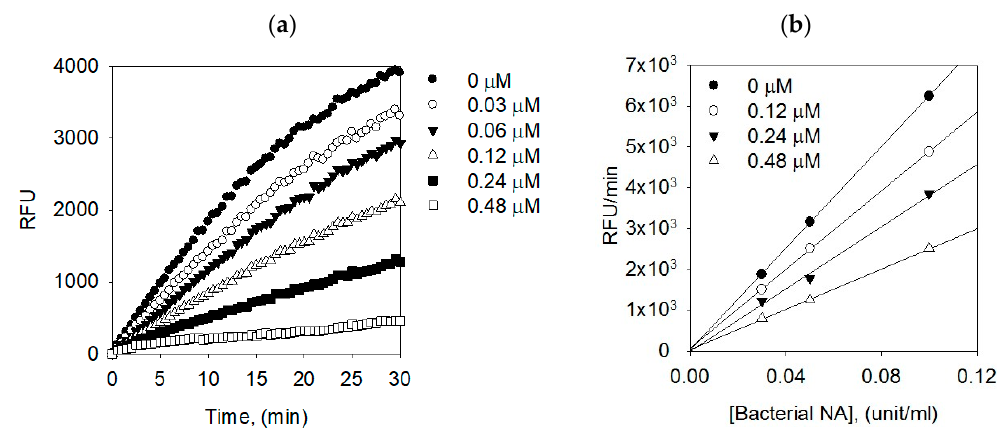
Figure 4. ( a ) Dose-dependent inhibition of bacterial neuraminidase inhibitory effects by compound 1 , and ( b ) Determination of the reversible inhibitory mechanism of compound 1